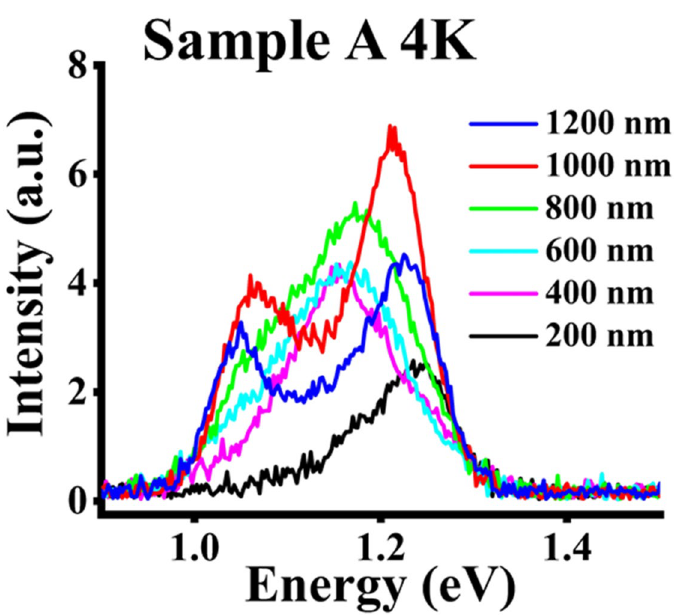
Figure 6. 4 K PL measurements for sample A for different pitch